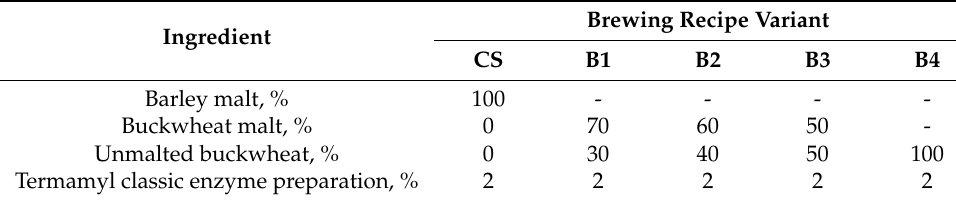
Table 2. Experimental variants of obtaining beer in laboratory